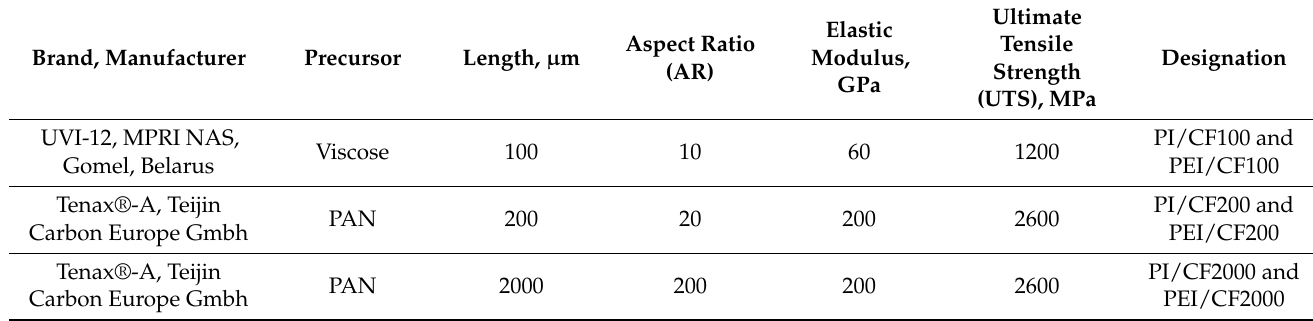
Table 2. The fillers for the PI- and PEI-based